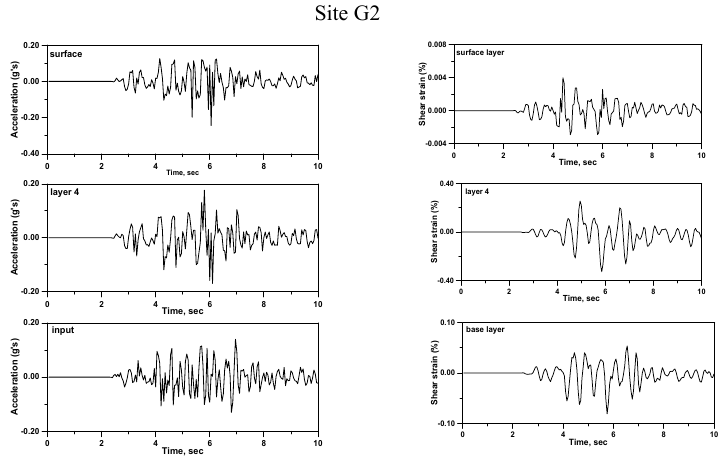
Fig. 25. Acceleration (left column) and strain (right column) time histories at different ground level.